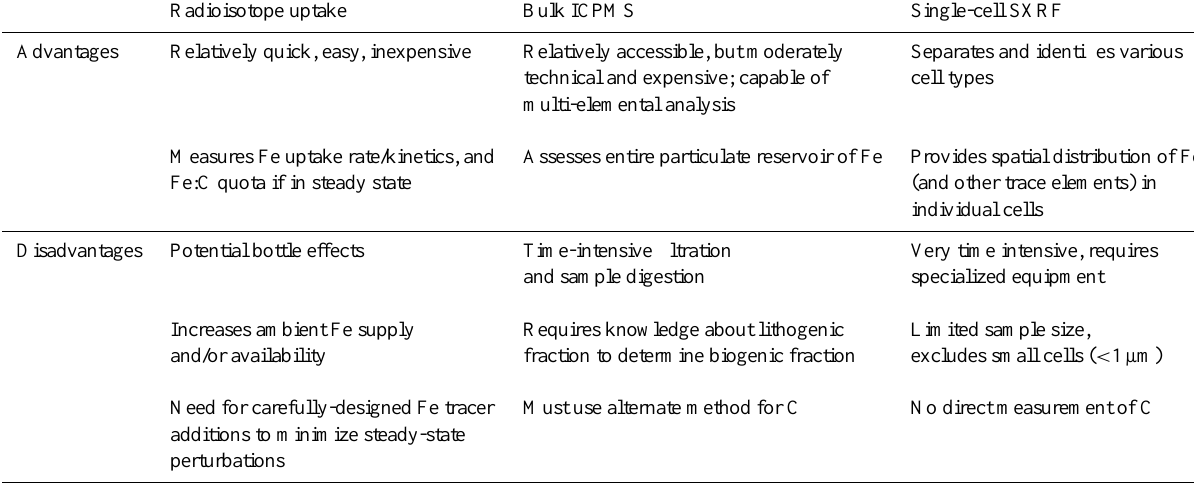
Table 7. Key advantages and disadvantages of Fe quota determination by radioisotope uptake, single-cell SXRF, and bulk ICPMS. Radioisotope